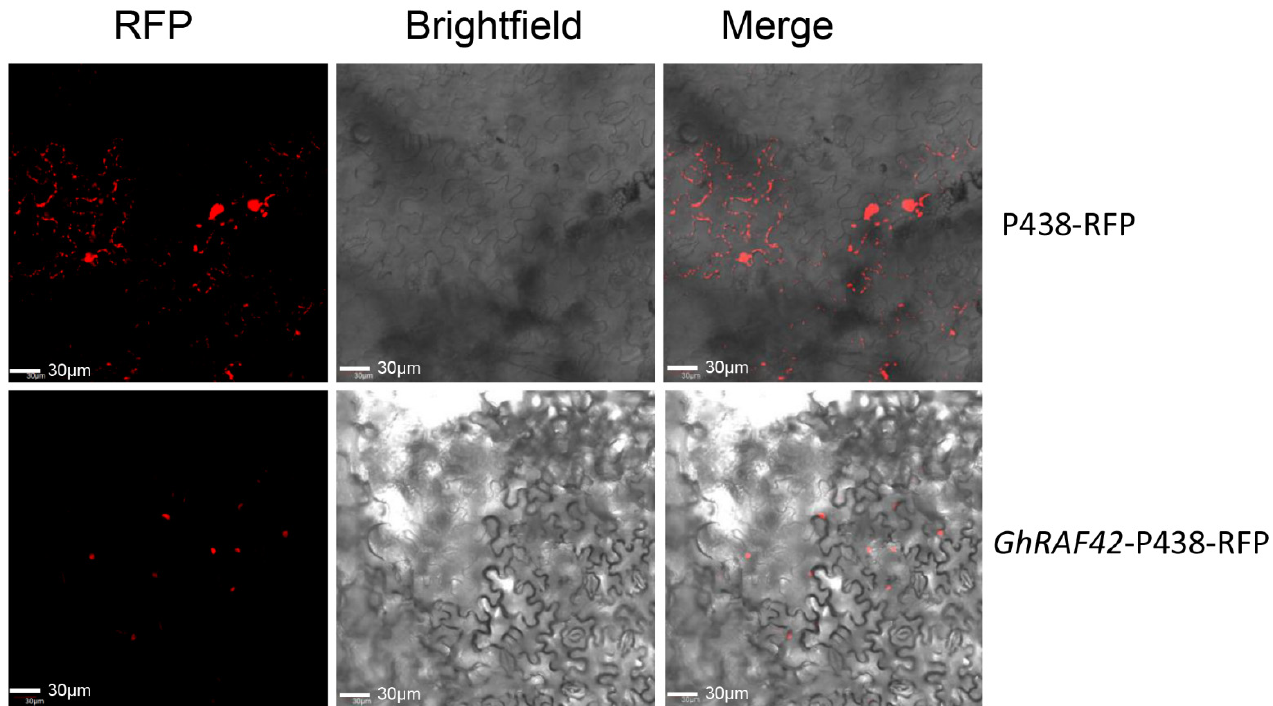
Figure 6. Subcellular location of GhRAF42 proteins. Red fluorescent proteins (RFP)-fusion proteins were transiently expressed in tobacco leaves. After 48 h, florescent genes reveled its presence in nucleus in tobacco leaves. Red represents the expression of RFP gene carried with (without) the GhRAF42 gene, the bar scale is 30 μ m.